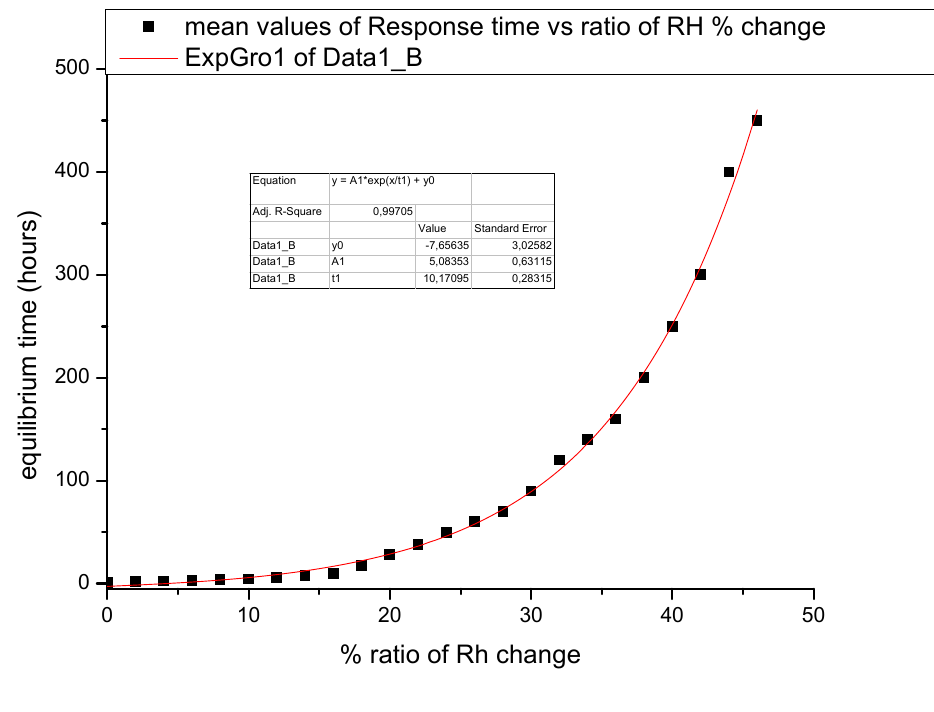
Figure 7. The mean equilibrium time vs. RH ratio of change demonstrating that the greater the ratio between loading and unloading conditions, the longer the time required to reach